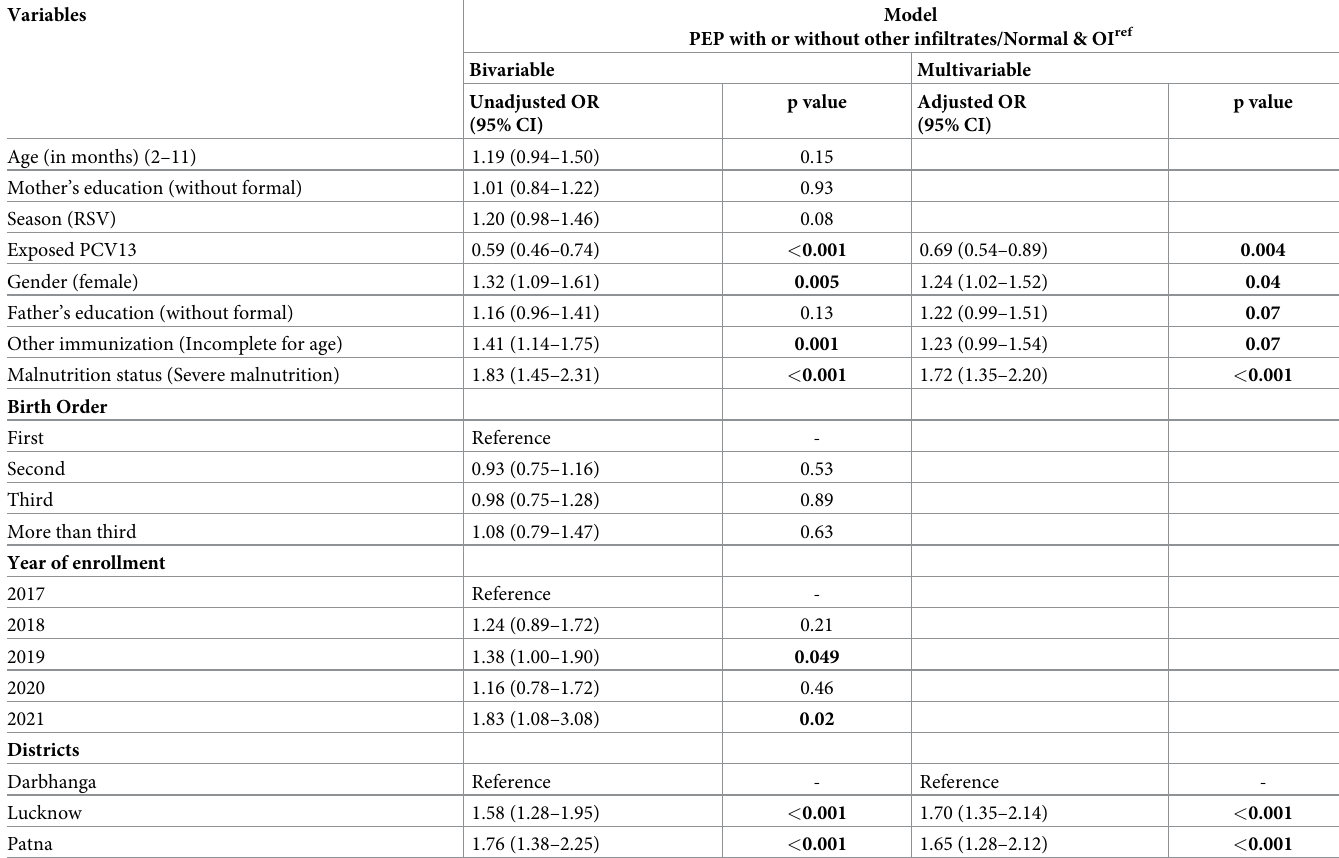
Table 3. Association of chest x-ray abnormalities with PCV13, controlling for independent